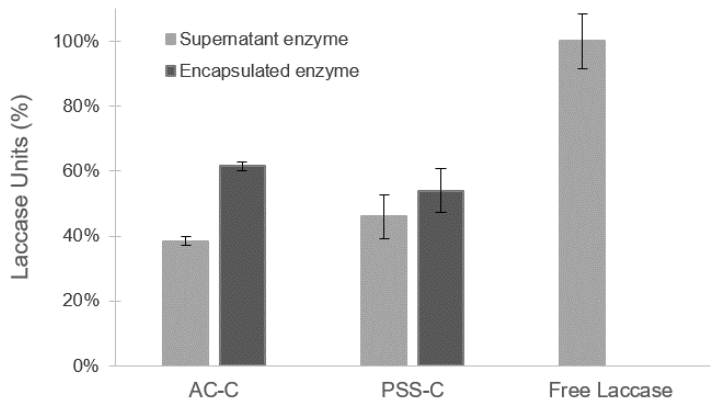
Figure 1. Measurement of laccase units for alginate/chitosan microcapsules (AC ‐ C) and poly(styrenesulfonate) microcapsules (PSS ‐ C) microcapsules and supernatant solutions in relation to initial free enzyme. Enzyme encapsulation was achieved with an efficiency greater than 50% for both types of polymers. Error bars correspond to standard deviations of experiments conducted in triplicate. Free laccase assays started with 2000 U L by diluting the stock solution containing LacI and − 1 and PSS-C in 10 mL of bu ff er solution at pH 4.0. PSS-C activity per mass unit (U mg ) approached